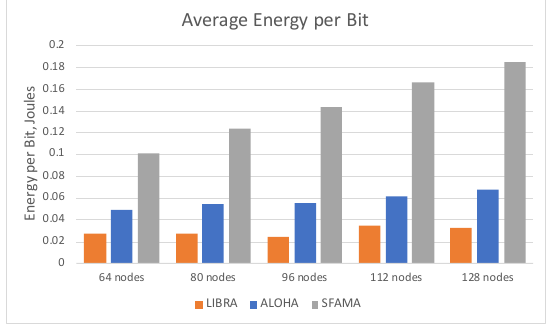
Figure 7. Average energy per bit, Joules.